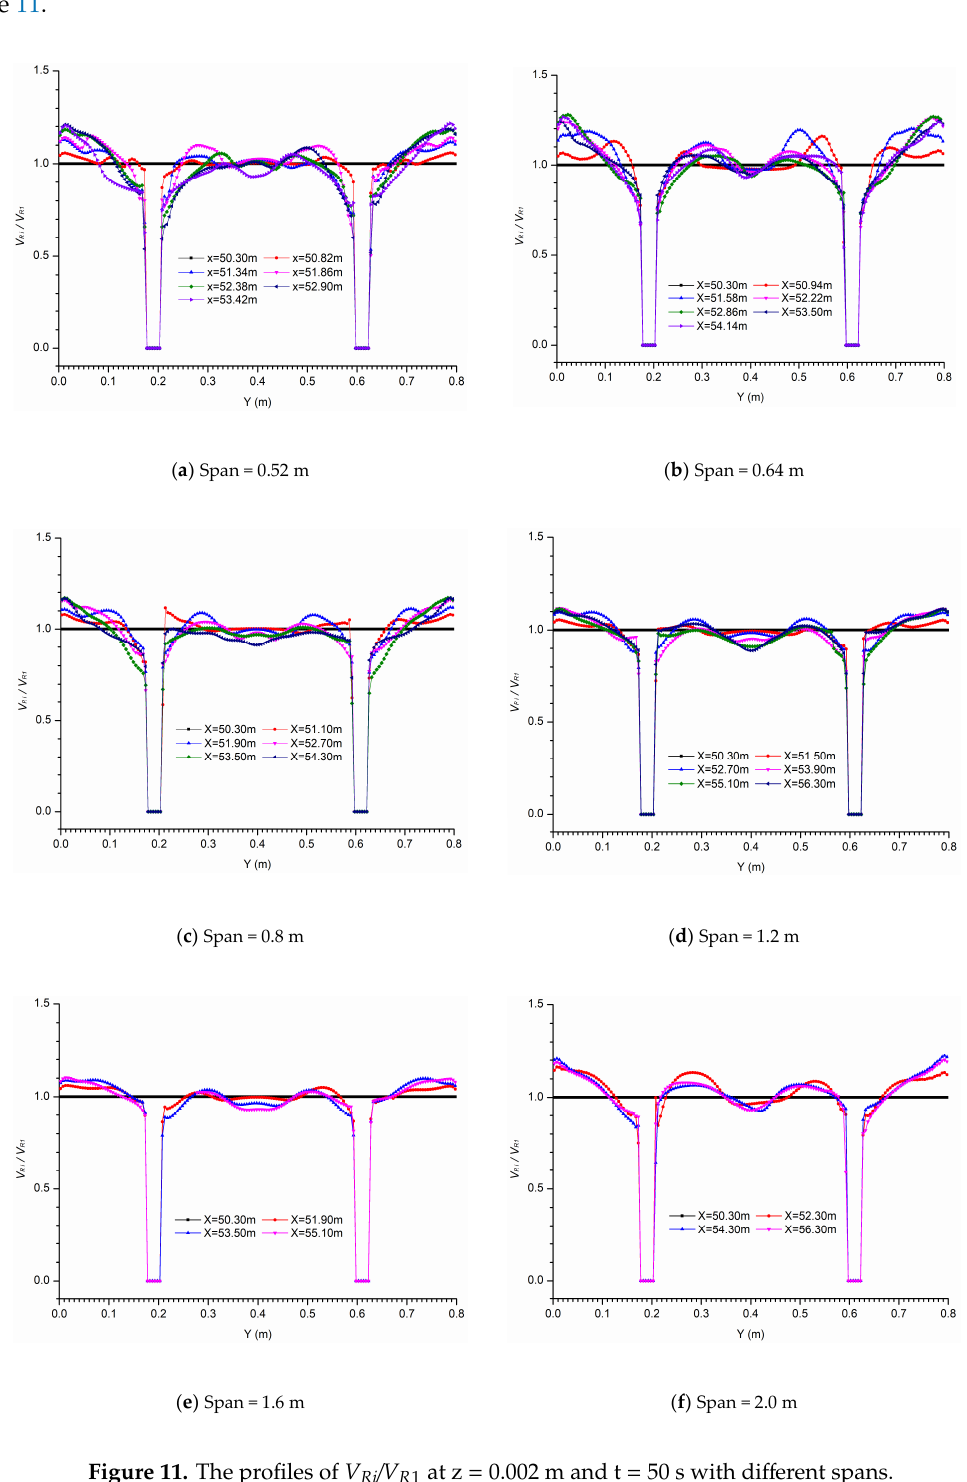
Figure 11. The profiles of V Ri / V R 1 at z = 0.002 m and t = 50 s with di ff erent